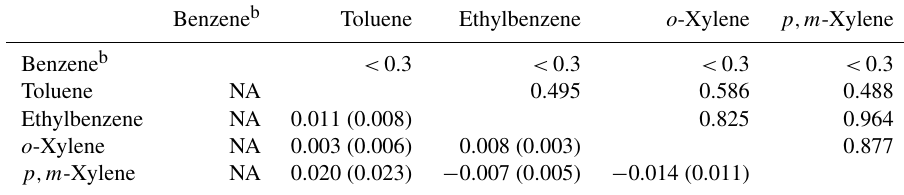
Table 4. Linear regression analysis of mixing ratio correlations. Values above the diagonal are R 2 and below are the intercepts a . Benzene b